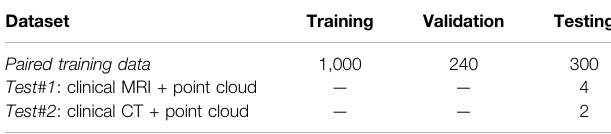
TABLE 2 | Summary of the data used in this